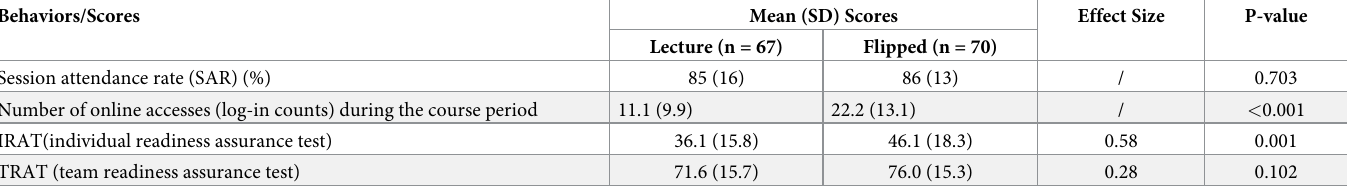
Table 1. Participant behaviors and outcome